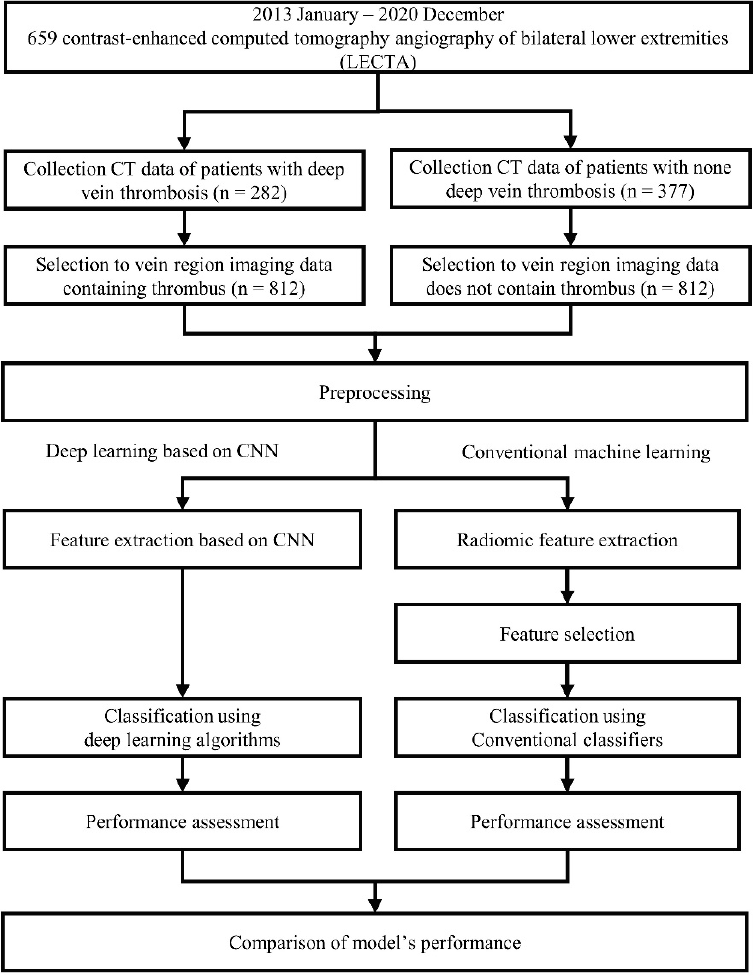
Figure 1. Flowchart of deep vein thrombosis (DVT) classification using deep learning models based on convolutional neural networks (CNN) and conventional machine learning.